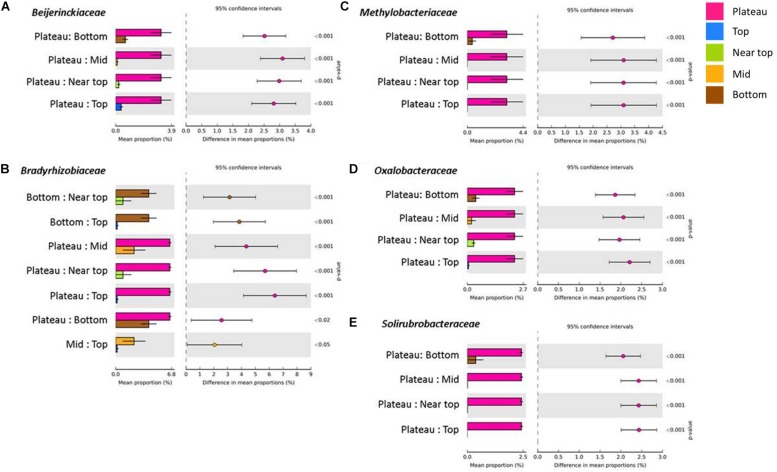
Families within the phyla Proteobacteria [(A)
Beijerinckiaceae, (B)
Bradyrhizobiaceae, (C)
Methylobacteriaceae and (D)
Oxalobacteraceae] and Actinobacteria [(E)
Solirubrobacteraceae] with significantly higher mean proportions in the plateau sections of T140 (Benjamini–Hochberg FDR P < 0.05, difference in mean proportion > 1.5%).